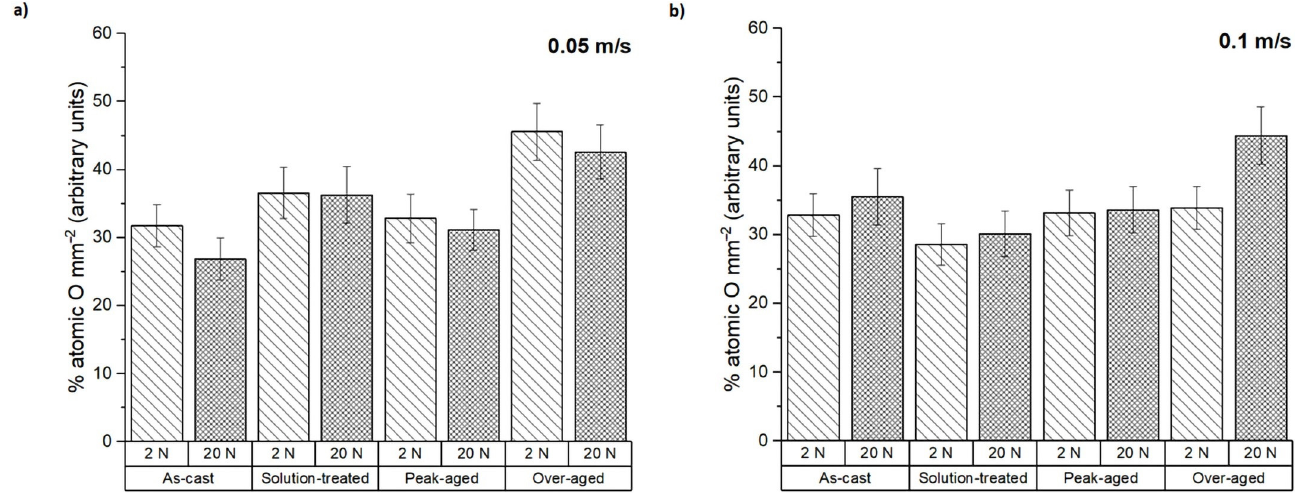
Figure 6. The atomic percentage of oxygen on the worn surface at sliding speeds of ( a ) 0.05 m s − 1 and ( b ) 0.1 m s − 1 .